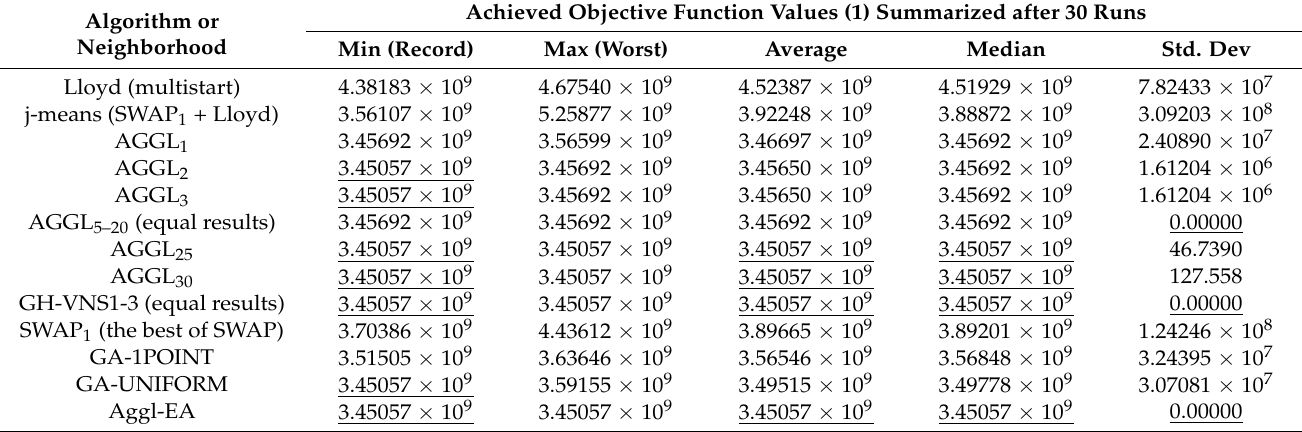
Table A1. Comparative results for BIRCH3 dataset. 10 5 data vectors in R 2 , p = 30 centers, time limitation 10 s. Algorithm or